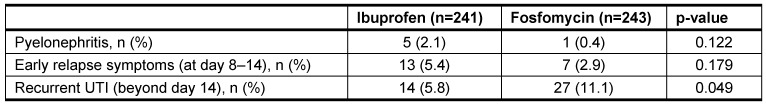
ICUTI: Recurrent UTI/complications day 0–28 (data ICUTI, intention to treat population [9])